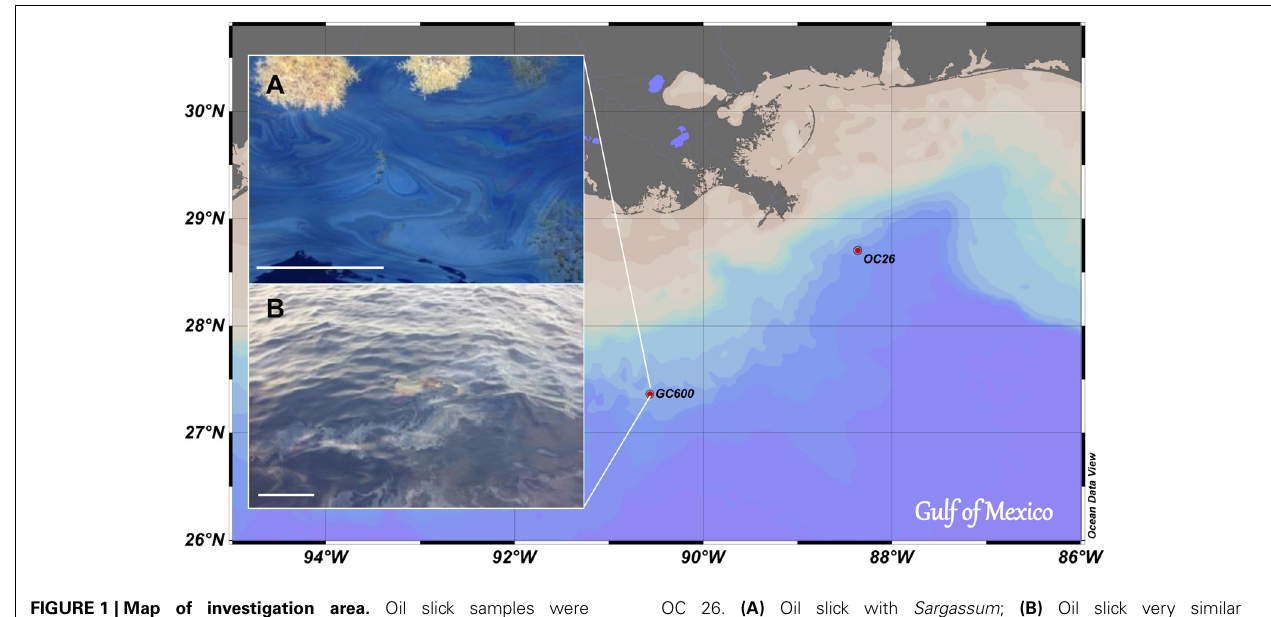
OC 26. (A) Oil slick with Sargassum ; (B) Oil slick very similar to the one sampled for this study (Picture taken by V. Asper, USM). Scale bars are 30cm.